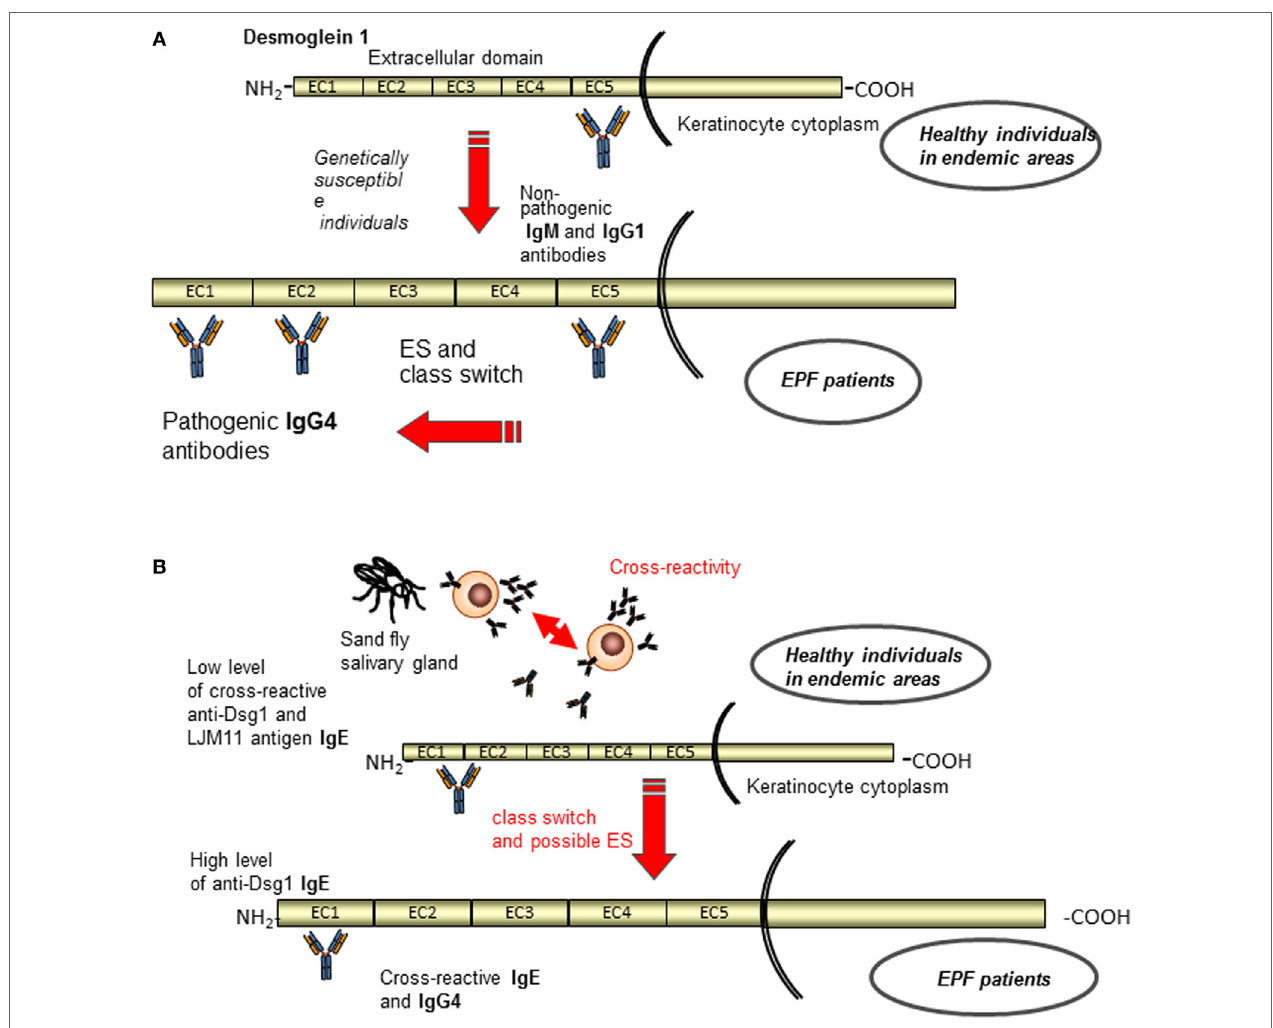
FiGURe 4 | Current etiopathogenetic model for endemic pemphigus foliaceus (EPF). A schematic representation of the antigenic regions recognized by autoantibodies of normal individuals and EPF patients. (A) Patients in the preclinical stage and healthy individuals from endemic areas possess IgG1 circulating autoantibodies that recognize non-pathogenic epitopes in the EC5, whereas when the disease developed appeared pathogenic IgG4 antibodies to EC1 and EC2 through class switch and ES (96–98). (B) In parallel, antigen mimicry that induces with or without ES an antibody switch from an epitope of salivary gland fly antigen (IgE) to a pathogenic epitope on the EC1 subdomain of Dsg1 (IgG4) is shown